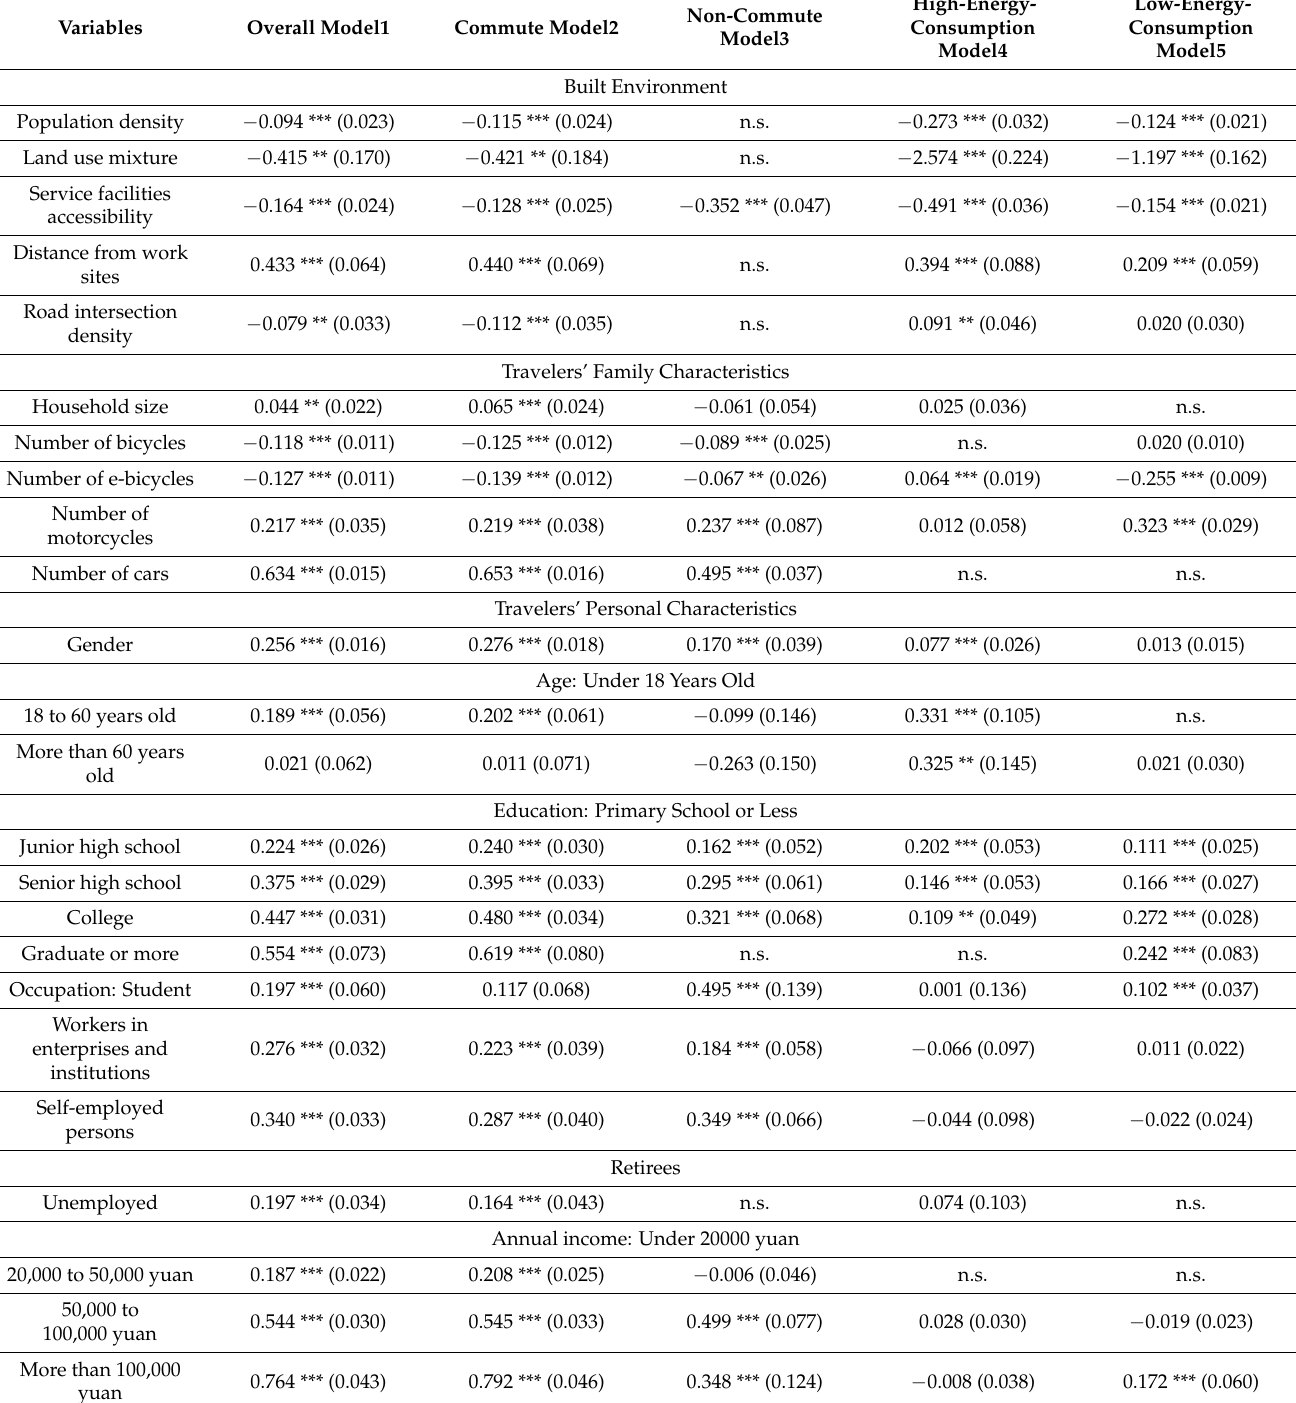
Table 3. Overall travel, different travel purposes and different travel modes regression